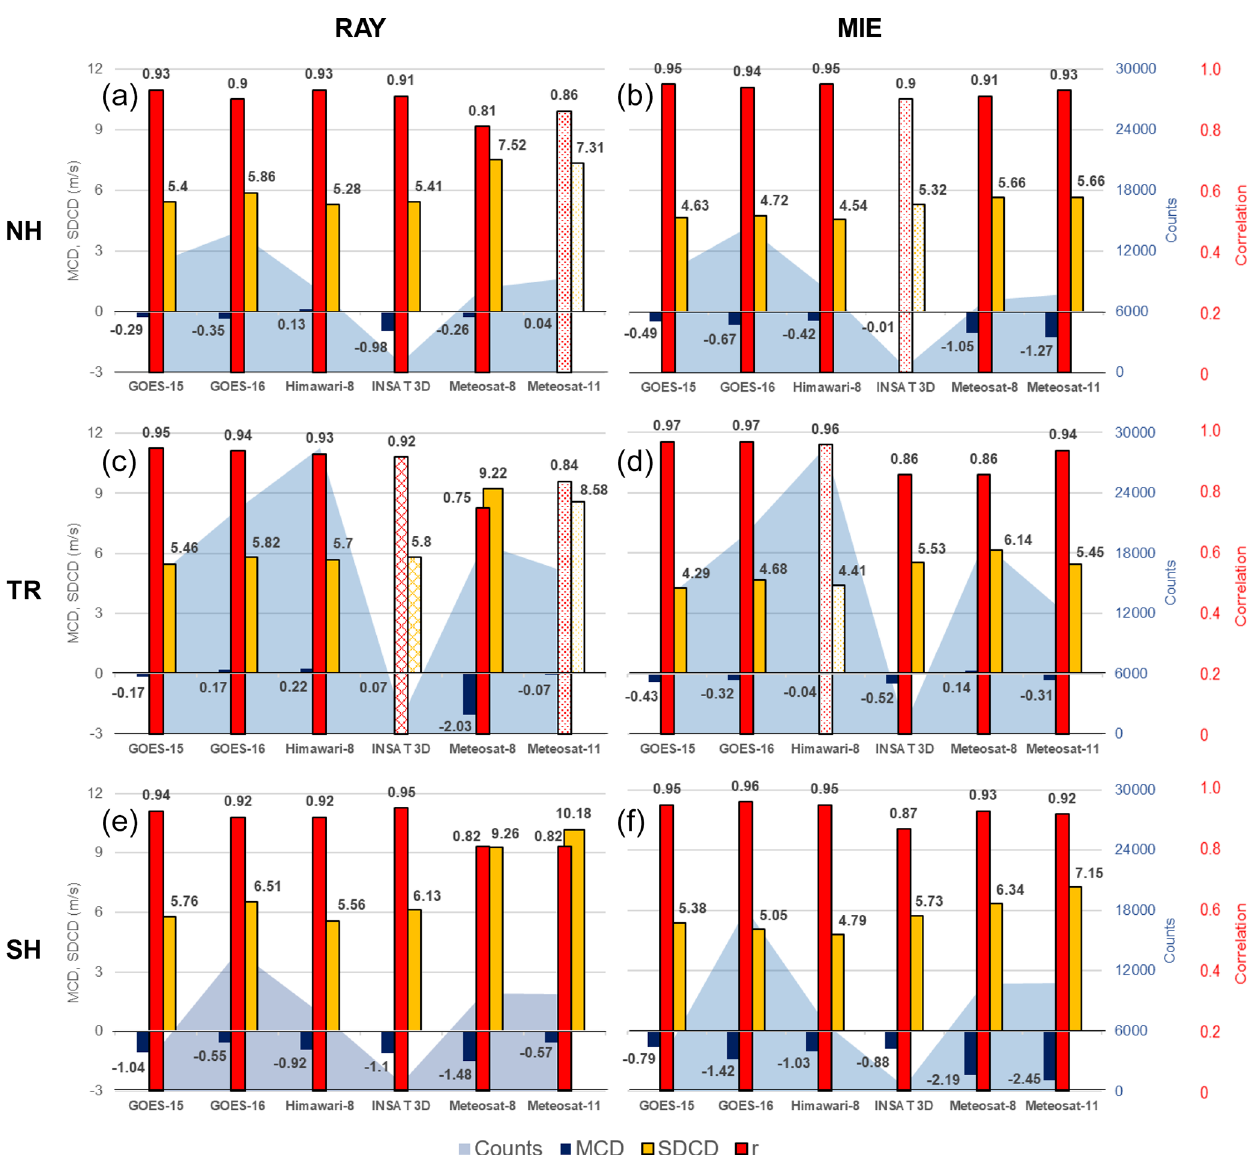
Figure 2. AMV–Aeolus global mean statistics in the (a, b) NH, (c, d) tropics (TRs), and (e, f) SH for GEO satellites that include the correlation ( r ) in red, mean co-location difference (MCD) between the HLOS winds (AMV–Aeolus) in navy blue, standard deviation of the co-location difference (SDCD) in yellow, and co-location counts as light blue shaded areas. Solid colors denote the 95% statistical significance, stripes denote the 90% statistical significance, and dots indicate the differences that are not statistically